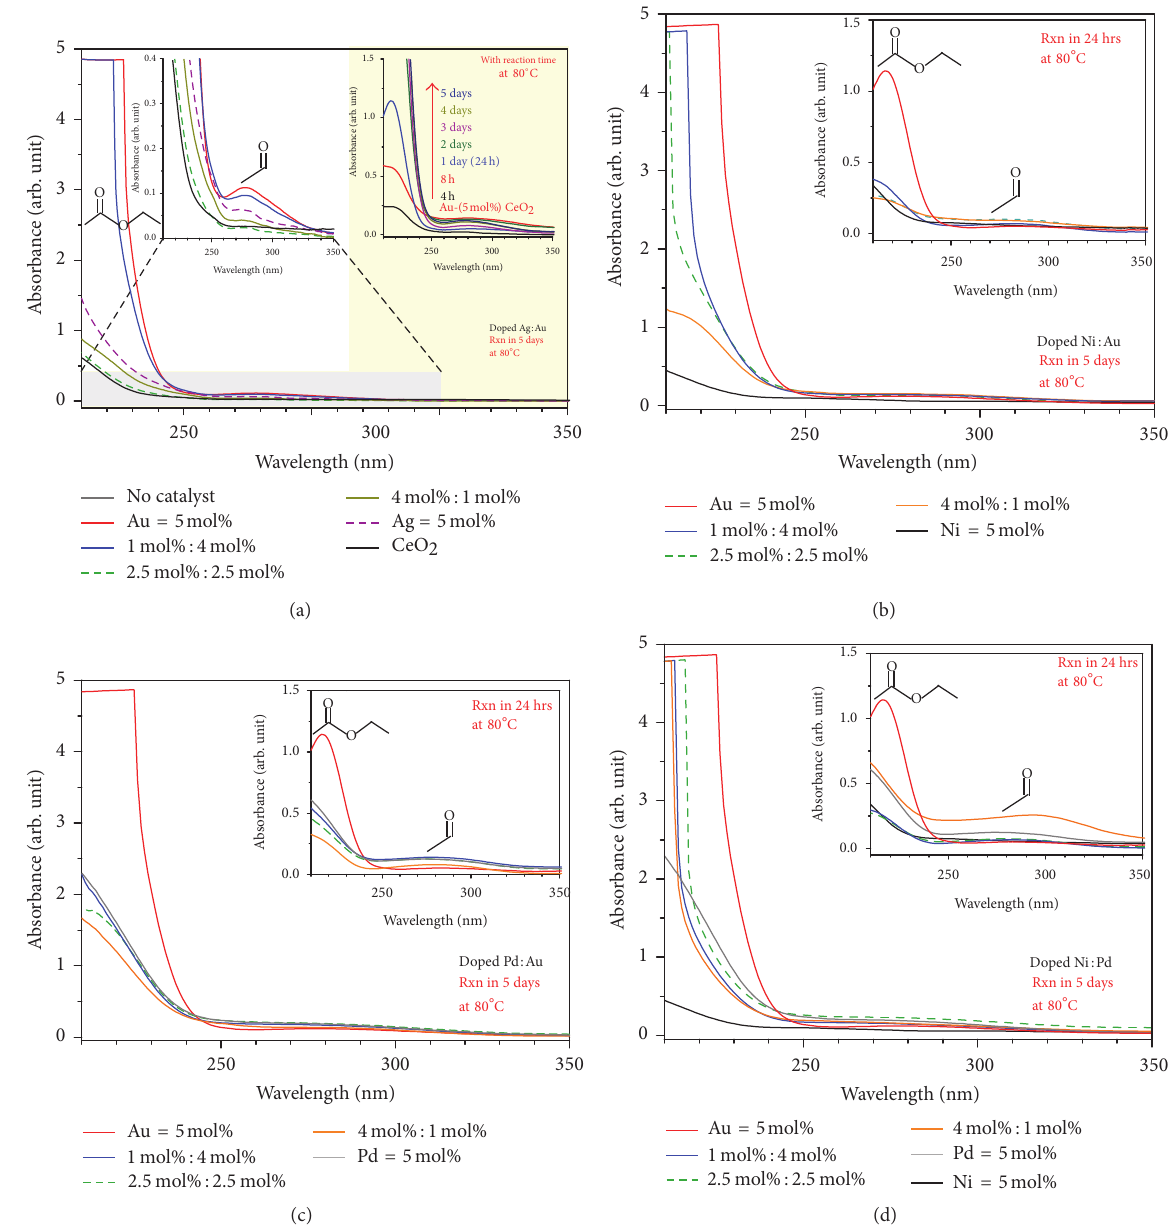
Figure 7: UV-visible absorption spectra of the ethanol oxidation with no catalyst, undoped CeO 2 , M doped (M = Ag, Au, Pd, and Ni) and MM 󸀠 codoped (Ag/Au (a), Ni/Au (b), Pd/Au (c), and Ni/Pd (d)) CeO 2 catalysts at 80 ∘ C for 5 days. The left inset in (a) shows the magnified spectra of the grey shadowed region. The right inset in (a) shows the UV-Vis absorption spectra of ethanol oxidation with the 5 mol.% Au doped CeO 2 catalyst at 80 ∘ C according to the reaction